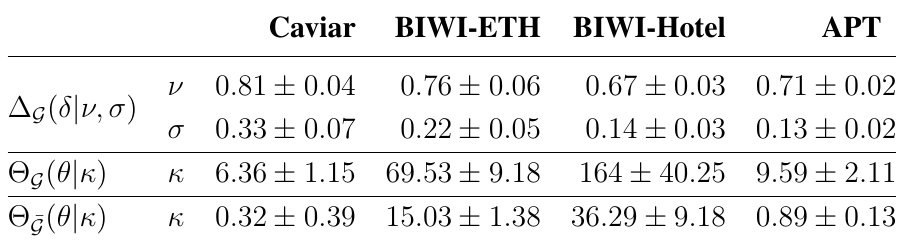
Table 2. The mean values and standard deviations of ν , σ and κ over the 50